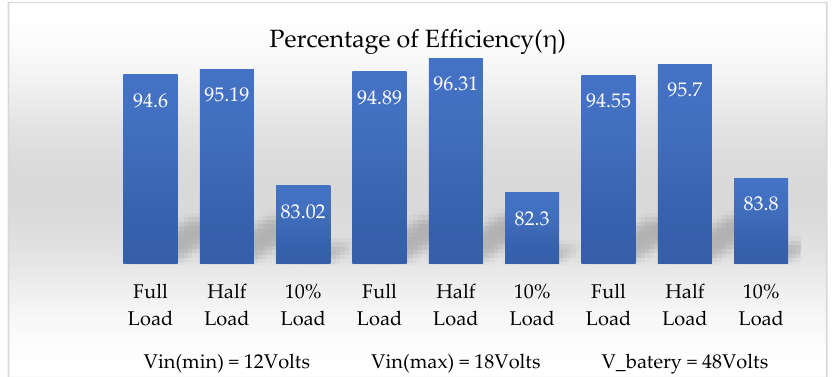
Figure 15. Efficiency of the current-fed isolated bidirectional DC-DC converter (CFIBDC) at various input voltages ( V in(min) , V in(max) and V o ) and loads (100%, 50% and 10% of load). Table 5. Comparison of current stress in different topologies with current stress of proposed con- verter CFIBDC (Percentage of output power (% P o ) Vs. Current of Topologies given with reference number).